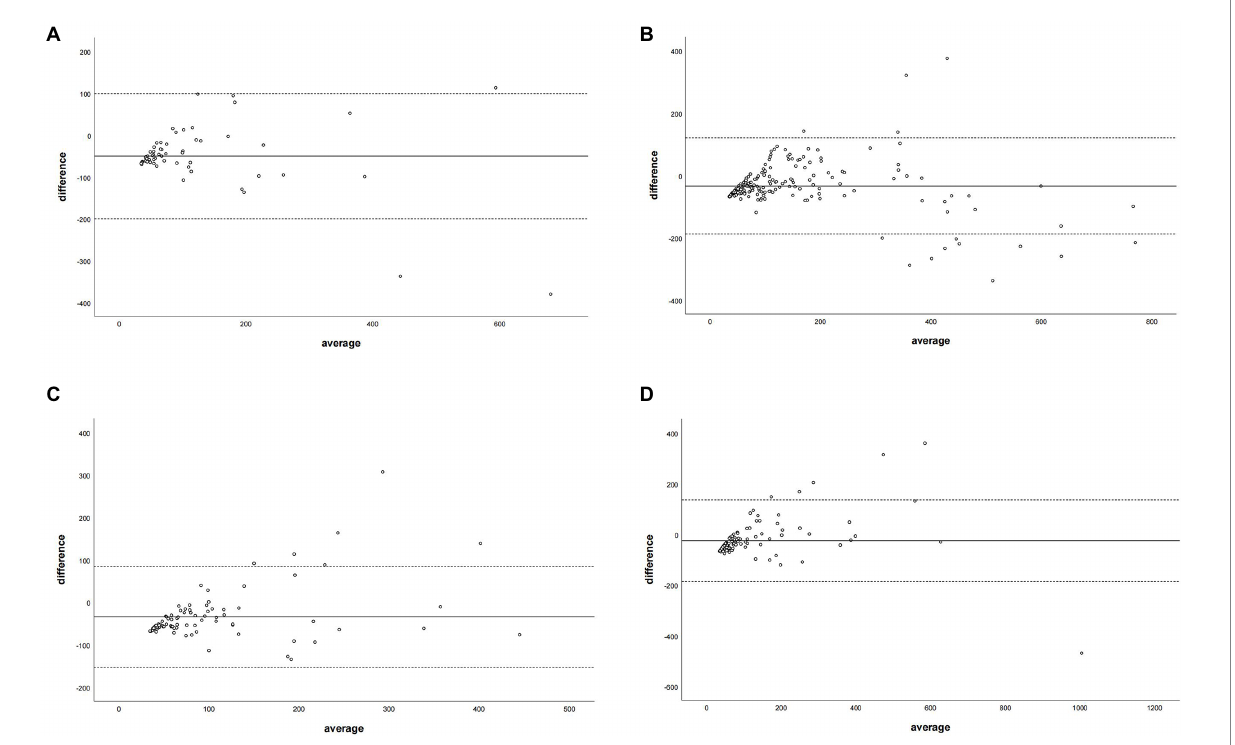
FIGURE 5 The Bland–Altman plot was used to describe the agreement of coronary artery calcium score between the non-contrast images and virtual non- contrast images (corrected by the regression equation of the overall calcium score) of each coronary artery branch. The average represented the mean value of calcium score from two images, and the difference represented the different values of calcium score from two images. Panel (A) denotes LM = left main coronary artery, panel (B) depicts LAD = left anterior descending branch, panel (C) depicts LCX = left circumflex branch, and panel (D) depicts RCA = right coronary artery.